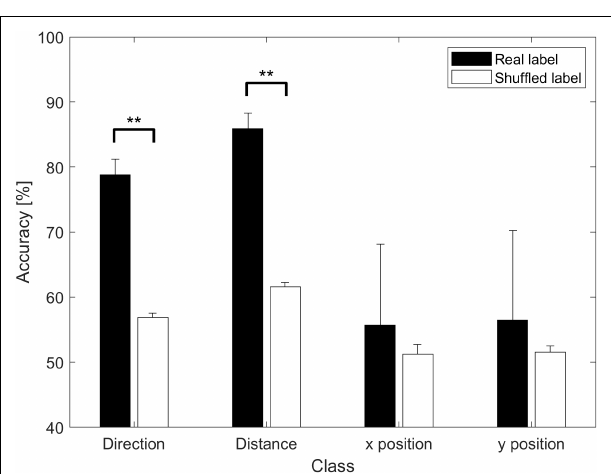
FIGURE 4 | Classification accuracy based on parameters. Accuracies are represented as the means of the averaged accuracy for all possible two-class classifications across all participants. ∗∗ p < 0.01. The black bar represents the result when real labels were used, while the white bar represents the result when shuffled labels were used. Significant differences were observed for direction and distance ( p < 0.01) but not for position ( p >